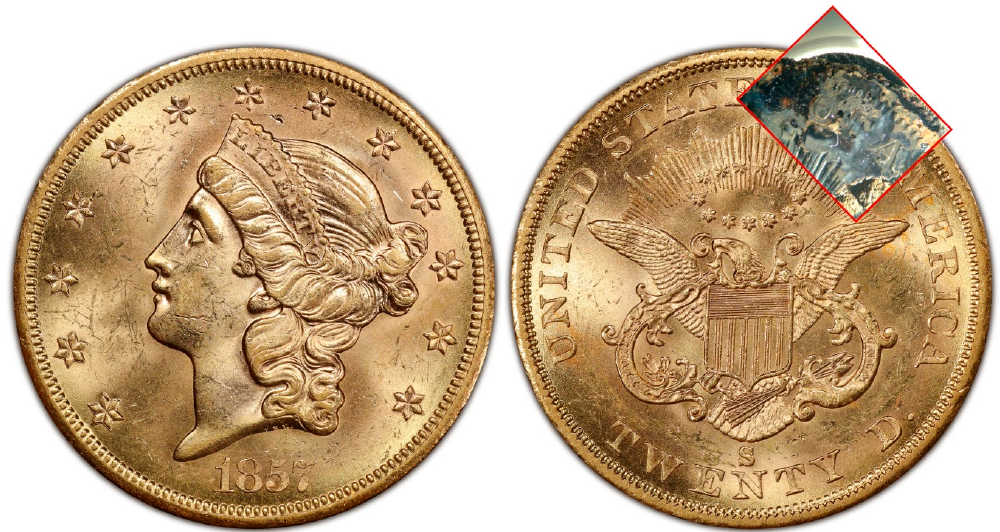
Figure 4. Image of an 1857-San Francisco mint $20 gold coin from the shipwreck, showing the preserved cast of the coin on a fragment of black crust (red box). The image of the crust has been inverted to align with the coin, as it is a negative-relief cast. The yellow areas on the crust are not gold, but hydrated iron oxides. Coin image courtesy of Professional Coin Grading